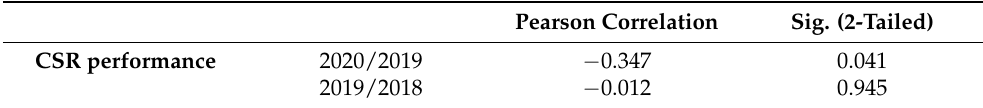
Table 5. Correlation analysis (CSR level vs. discretionary